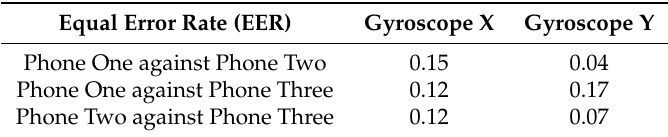
Table 4. Equal Error Rate (EER) for Gyroscope X and Gyroscope Y for a single day’s data in the first set of measurements